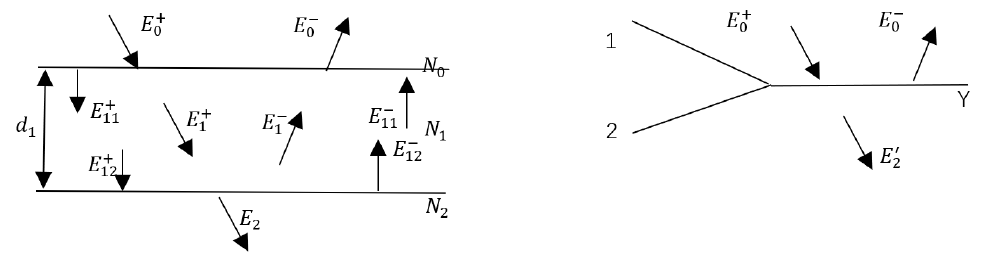
Figure 4. Schematic diagram of the equivalent interface.